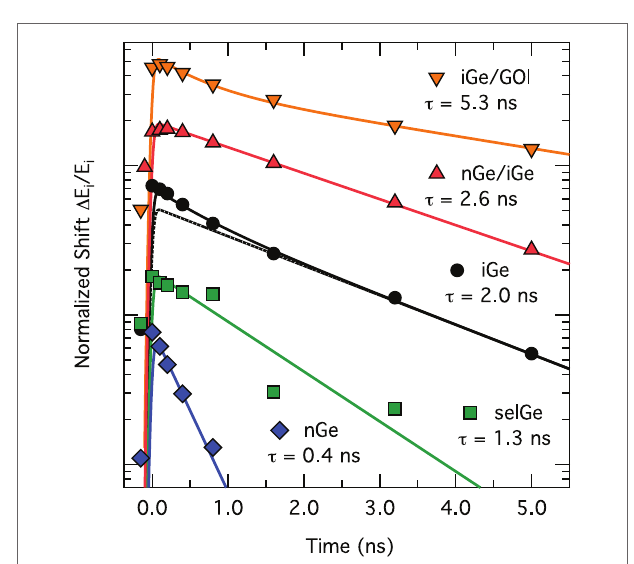
FiGURe 7 | Time-resolved infrared reflection and transmission spectroscopy: (A) mid-infrared reflection spectra of Ge on Si expressed as the ratio of pumped ( R P ) and unpumped reflection ( R U ) for varying excitation power at a pump–probe delay of 250 ps . The resonance in the spectra is attributed to the carrier plasma frequency, which enables to extract